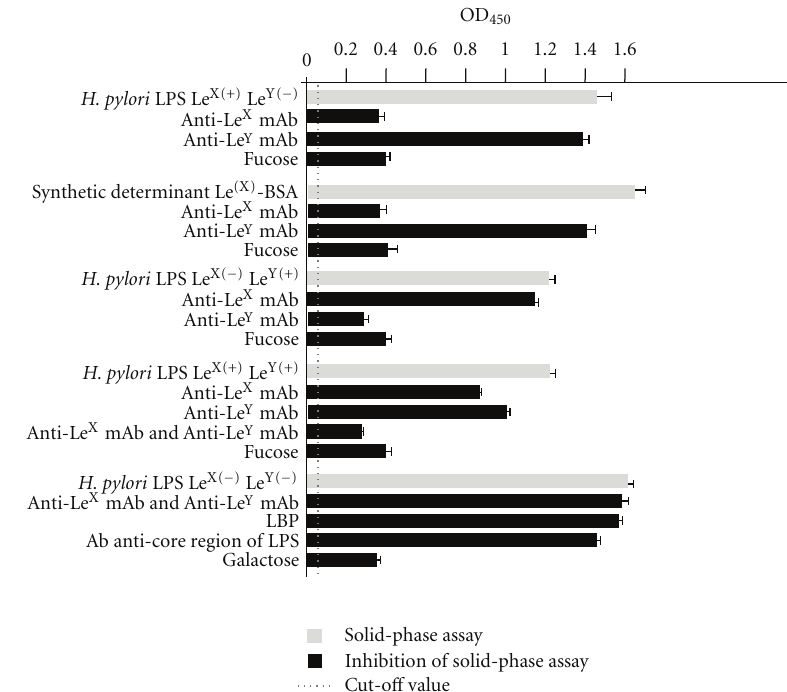
Figure 2: The binding of H. pylori LPS with or without expression of Le XY determinants and synthetic Le X -BSA with a soluble DC-SIGN receptor. The binding estimated by the solid-phase assay (grey bars). The specificity of binding estimated by the solid-phase inhibition assay (black